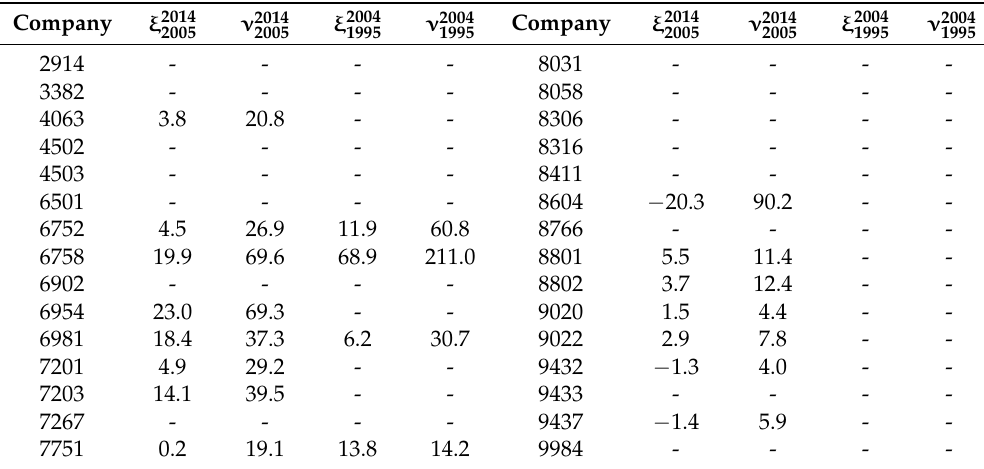
Table A3. Estimated parameters ξ ( % ) and ν ( % ) , for each company of TPXC30 index.